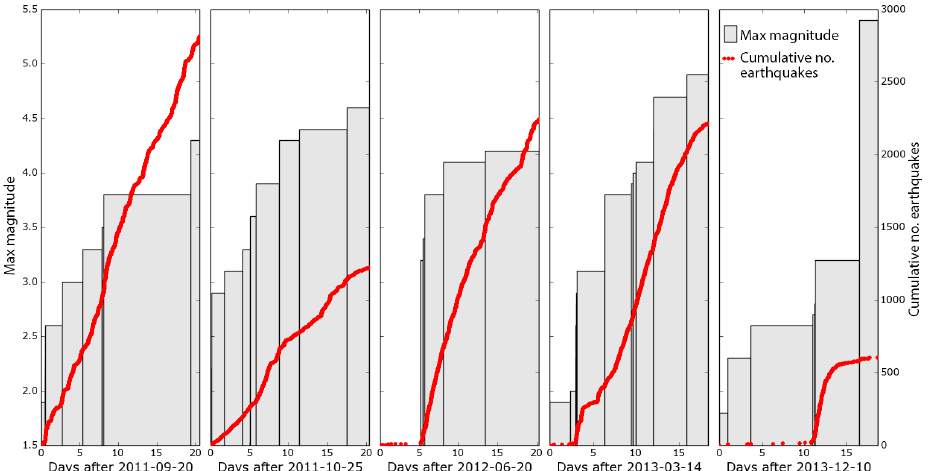
Figure 3. Time evolution of the daily count of VT events (red dots) and maximum magnitudes (gray bars) during the earthquake swarms of the El Hierro seismo-volcanic